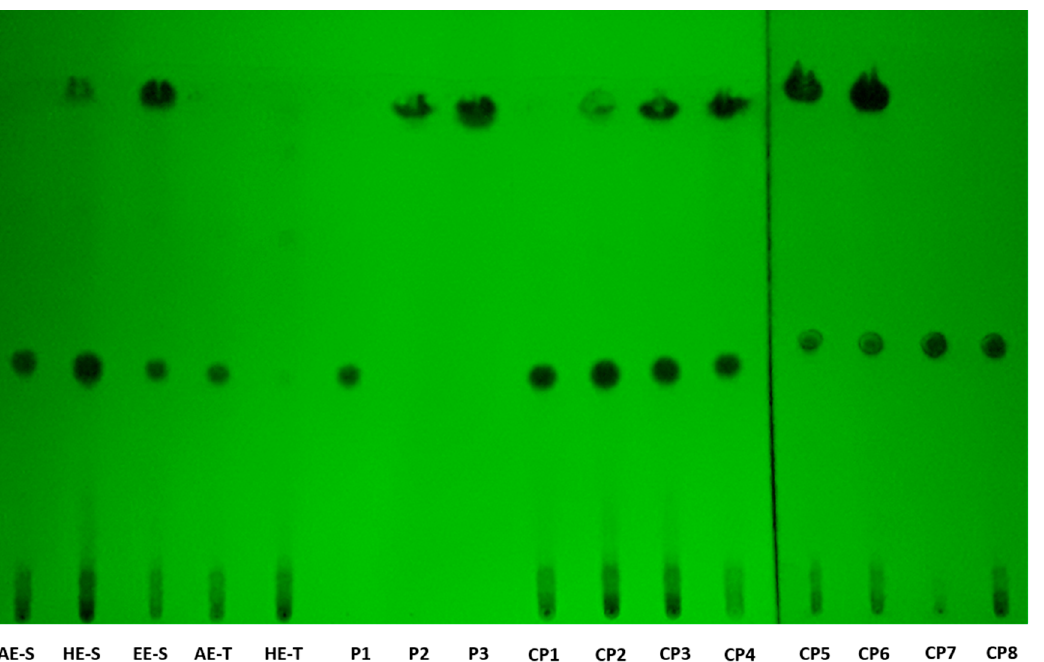
Figure 2. Thin-layer chromatography (TLC) chromatogram of Salvia officinalis extracts and standards.